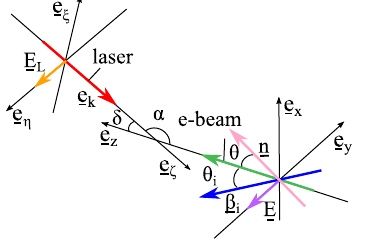
FIG. 1. Interaction geometry. ð e x ; e y ; e z Þ : laboratory frame. Laser: ð e ξ ; e η ; e k Þ : laser proper reference frame; red arrow: propagation direction, orange arrow: polarization versor. Electron beam: green arrow: average electron motion direction, blue arrow: ith electron motion direction, θ i : angle of the ith electron. α : collision angle, δ ¼ π − α . Radiation: pink arrow: observer direction, θ : observer angle, violet arrow: radiation polarization versor.